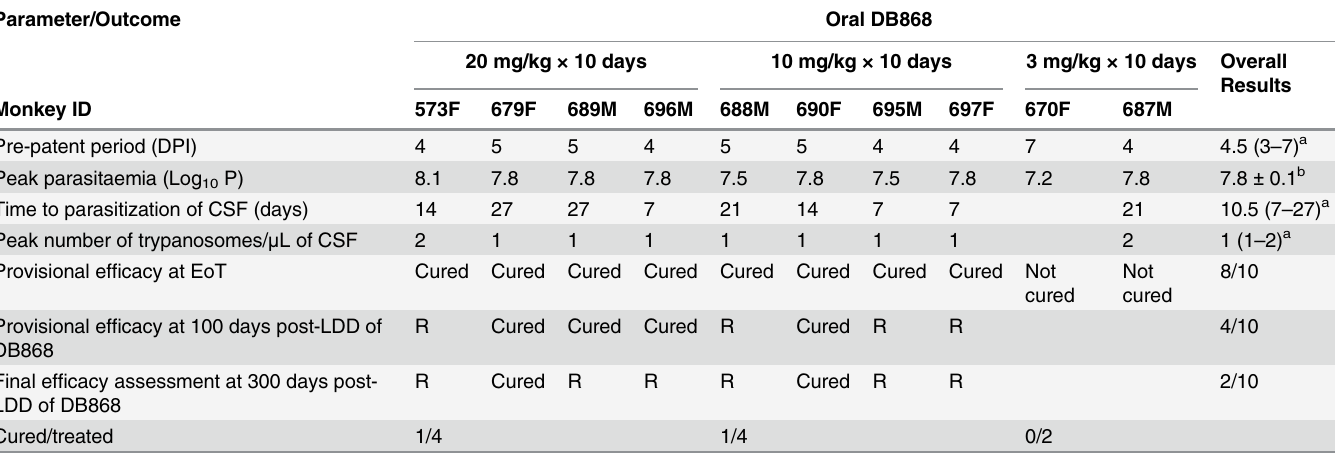
Table 2. Ef fi cacy of oral prodrug DB868 against second stage T. b. rhodesiense infection in vervet